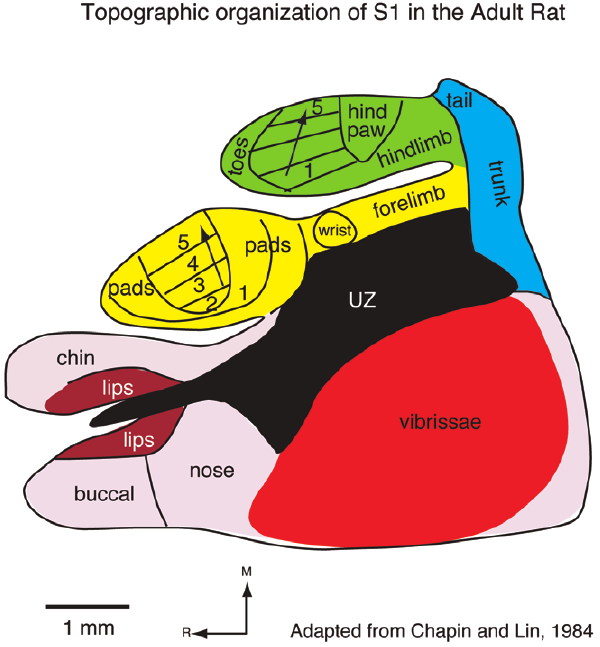
Figure 1. The topographic organization of the primary somatosensory area in adult rats. As in all other mammals examined, the contralateral body is represented from hindlimb to forelimb to face in a mediolateral progression. The individual toes of the hindpaw and digits of the forepaw are represented rostrally, the proximal limbs caudal to this and the trunk most caudally. In rats, there is a large magnification of the vibrissae of the face. In this and following figures, the head representation is shaded red, the forelimb represen- tation is yellow, the hindlimb representation is green, and the trunk representation is blue. In this figure, unresponsive zones (UZ) are represented in black. Modified from Chapin and Lin, 1984.